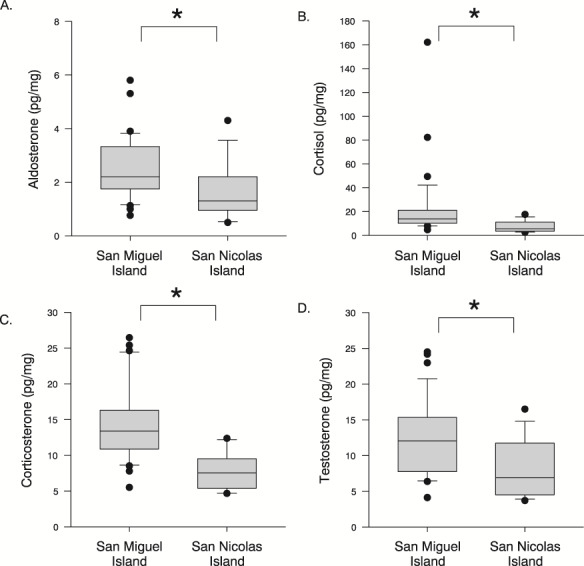
Concentrations of (A) aldosterone, (B) cortisol, (C) corticosterone, and (D) testosterone were all significantly higher in California sea lion pups sampled on San Miguel Island (n = 33) compared to San Nicolas Island (n = 13). There were no differences in hormone concentrations amongst female and male pups. Box plot: grey box includes data between the 25th and 75th percentile, with a line within each box denoting the median, the whiskers denote the error bars (10 and 90% percentile), and the circles denote outliers